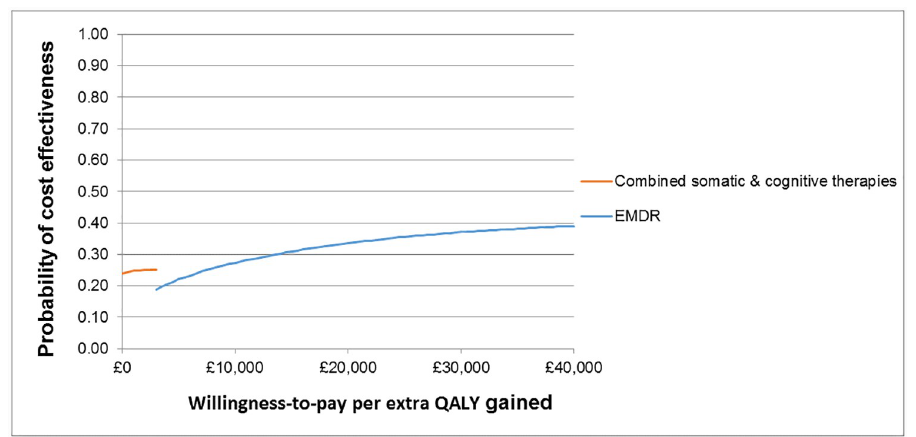
Fig 3. Cost-effectiveness acceptability frontier: Base-case